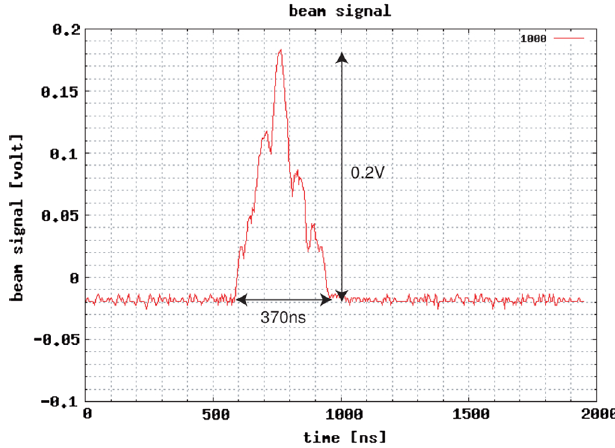
FIG. 18. (Color) Bunch shape without the second harmonic rf. The full width of the bunch is 370 ns.